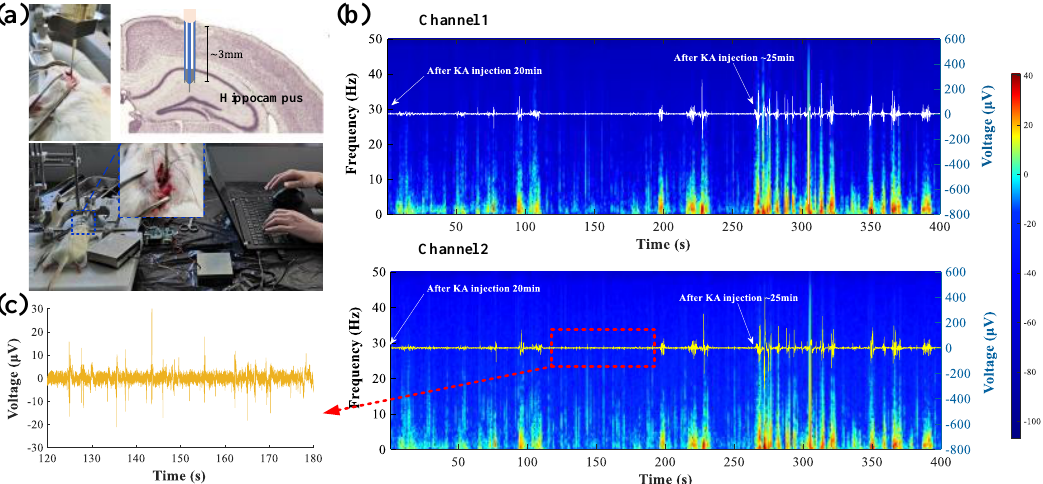
Figure 4. Acute in vivo neural signal recording experiment. ( a ) Photo image of animal experiment setup; ( b ) dual-channel iEEG signals and time frequency spectra after KA injection; ( c ) epileptic wave (Channel 2).